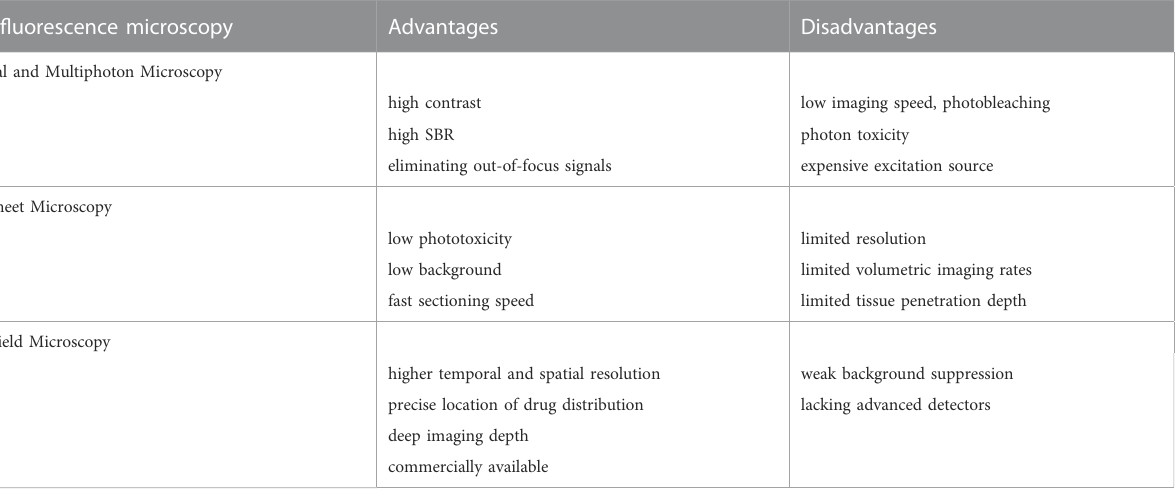
TABLE 2 The summary of advantages and disadvantages of NIR-II fl uorescence